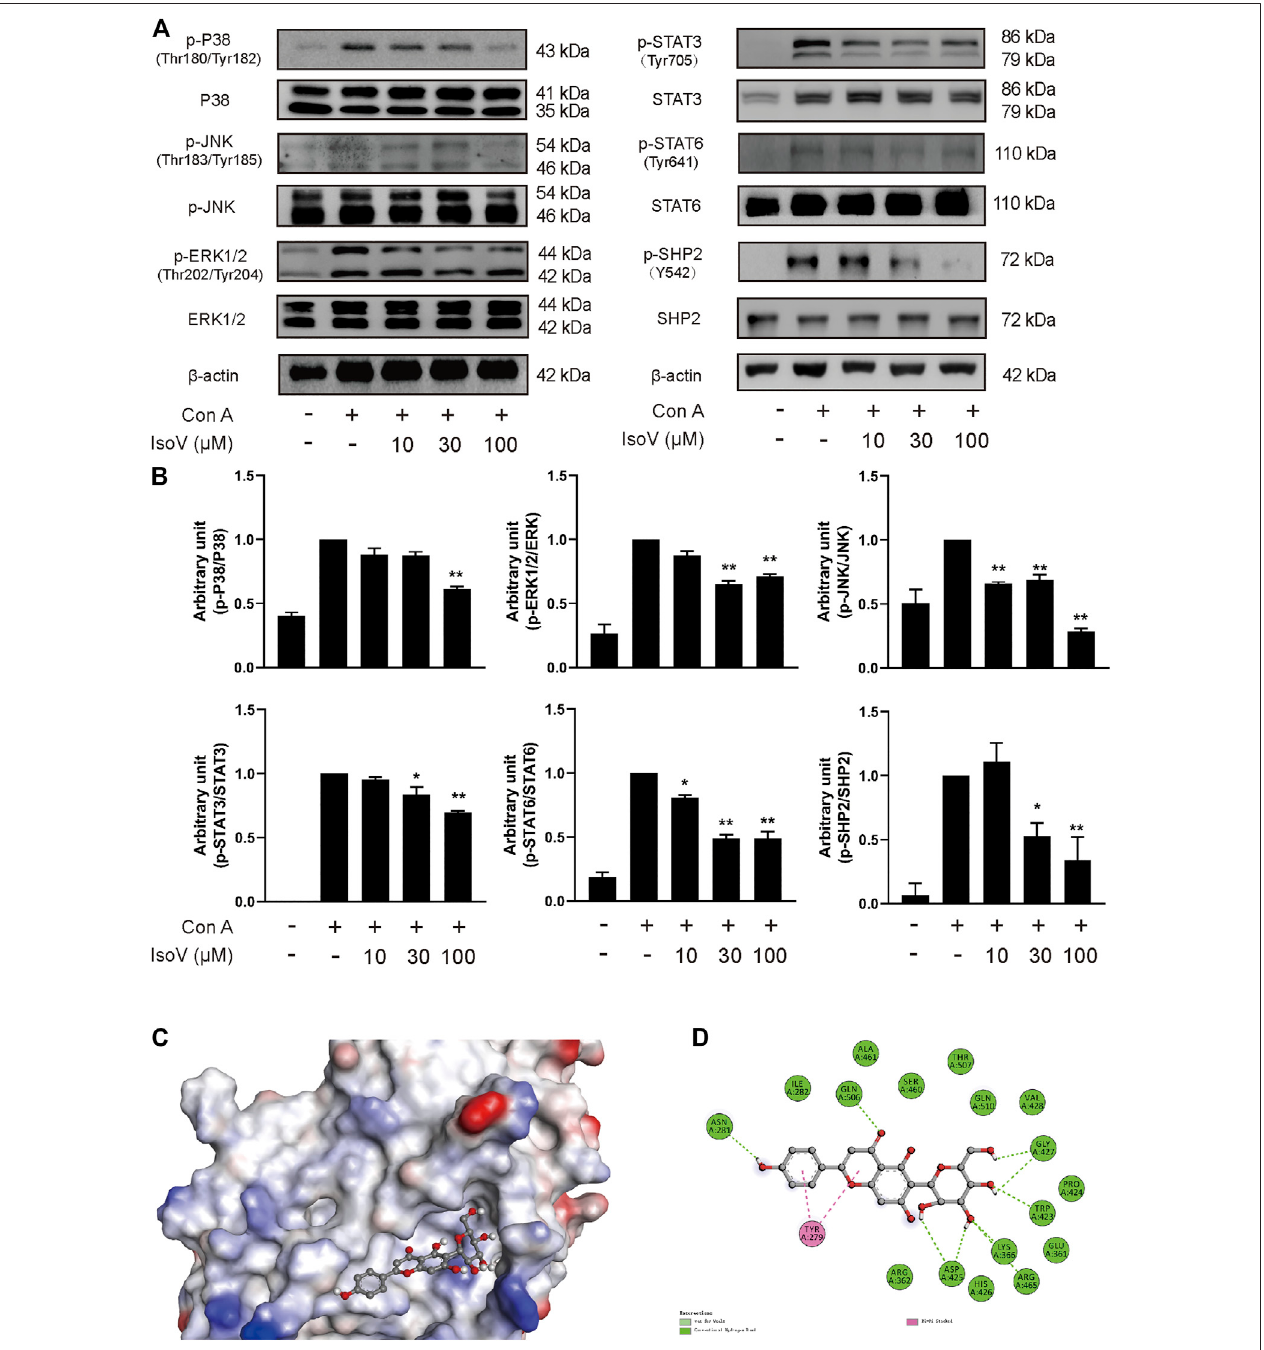
FIGURE6| IsovitexininhibitsMAPK,STATsignalinganddecreasesthephosphorylatedSHP2levelinConA – activatedTcells. (A,B) Tcellsisolatedfromthelymph nodes of Balb/c mice were stimulated with 5 μ g/ml Con A and various doses of isovitexin for 24 h. The protein levels of p-P38, p-JNK, p-ERK1/2, p-STAT3, p-STAT6, p-SHP2 in T cells were measured by western blotting, and the relative band density was analyzed using ImageJ Data are mean ± SEM and are representative of at leastthreeindependentexperiments.Thegroupingofgelswerecroppedfromdifferentpartsofthedifferentgels.Signi fi cantdifferencesareexpressedas* p < 0.05, ** p < 0.01 vs. the Con A group. (C,D) The induced fi t docking analysis of isovitexin and SHP2 protein (PDB:3o5x). Hydrogen bonds and π - π stacking were indicated with green and pink dot line, respectively.